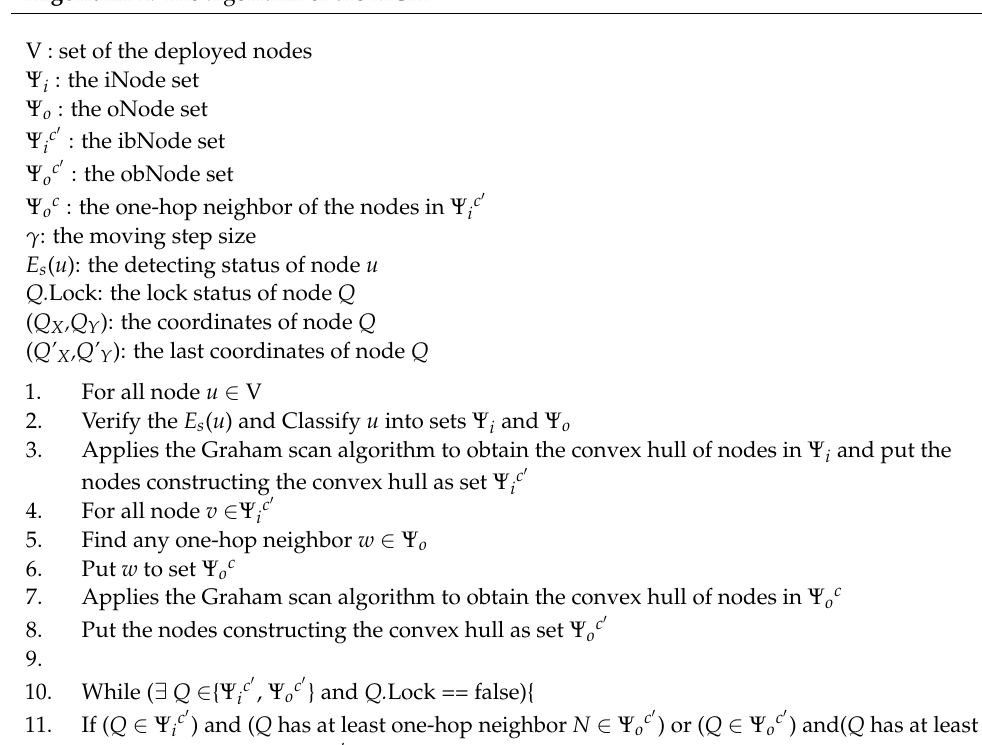
Algorithm 2. The algorithm of the